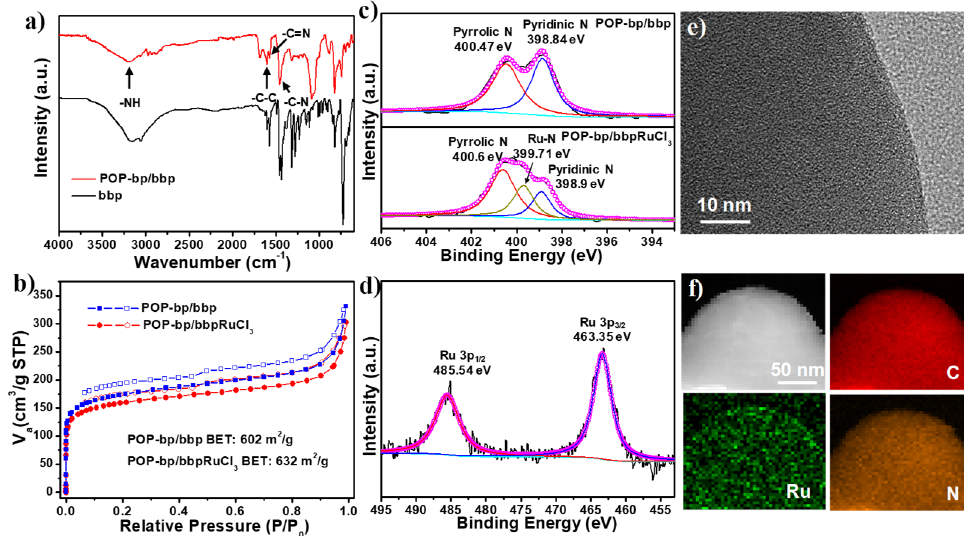
Figure 1. ( a ) Fourier transform infrared (FT-IR) spectra of POP-bp/bbp and POP-bp/bbpRuCl 3 . ( b ) N 2 sorption isotherm for POP-bp/bbp and POP-bp/bbpRuCl 3 at 77 K. ( c ) N1s X-ray photoelectron